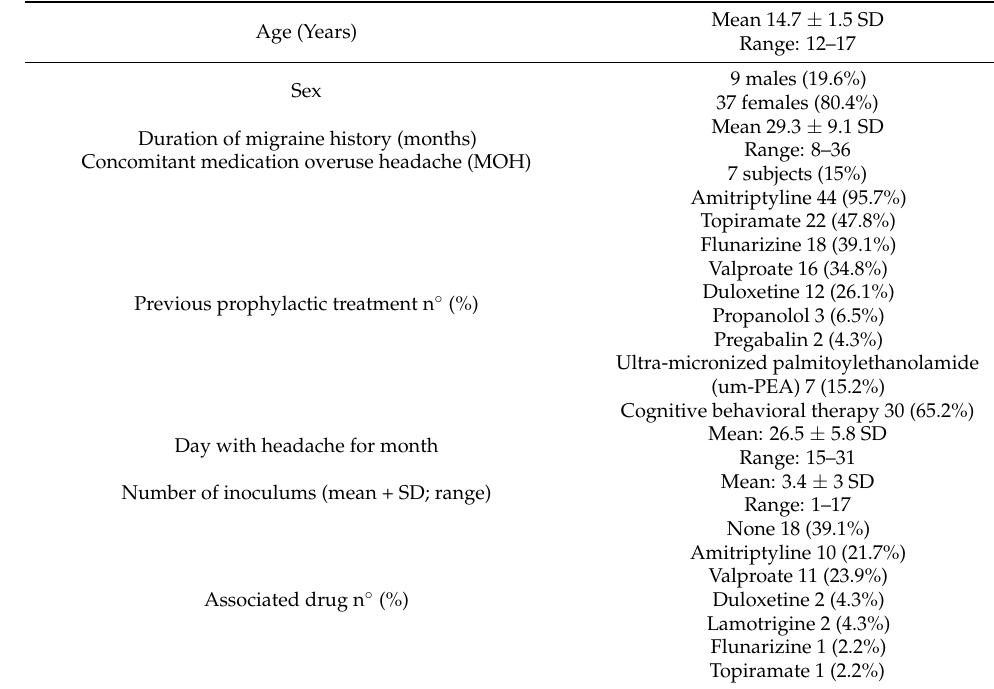
Table 1. Features of 46 patients receiving just a dose of OBT-A. TPM: topiramate; AMY: amitripty- line; FNZ: flunarizine; VPA: valproate; SNRI: serotonin-norepinephrine reuptake inhibitor; PPN: propranolol; PRG: pregabalin; um-PEA: ultra-micronized